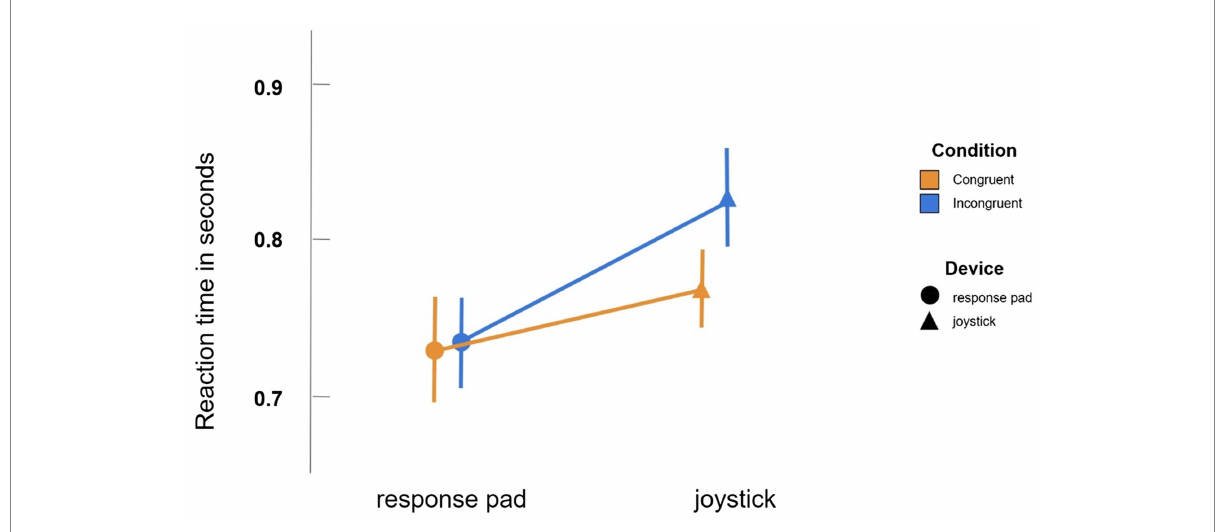
FIGURE 5 Interaction between condition and device. Participants were significantly slower for the incongruent condition when using the joystick but not when using the response pad. Note that the standard error in the figure suggests a bigger divergence than the actual LMM. This is because the model uses an inter-subject comparison (random variable ‘subject’), but the standard error does